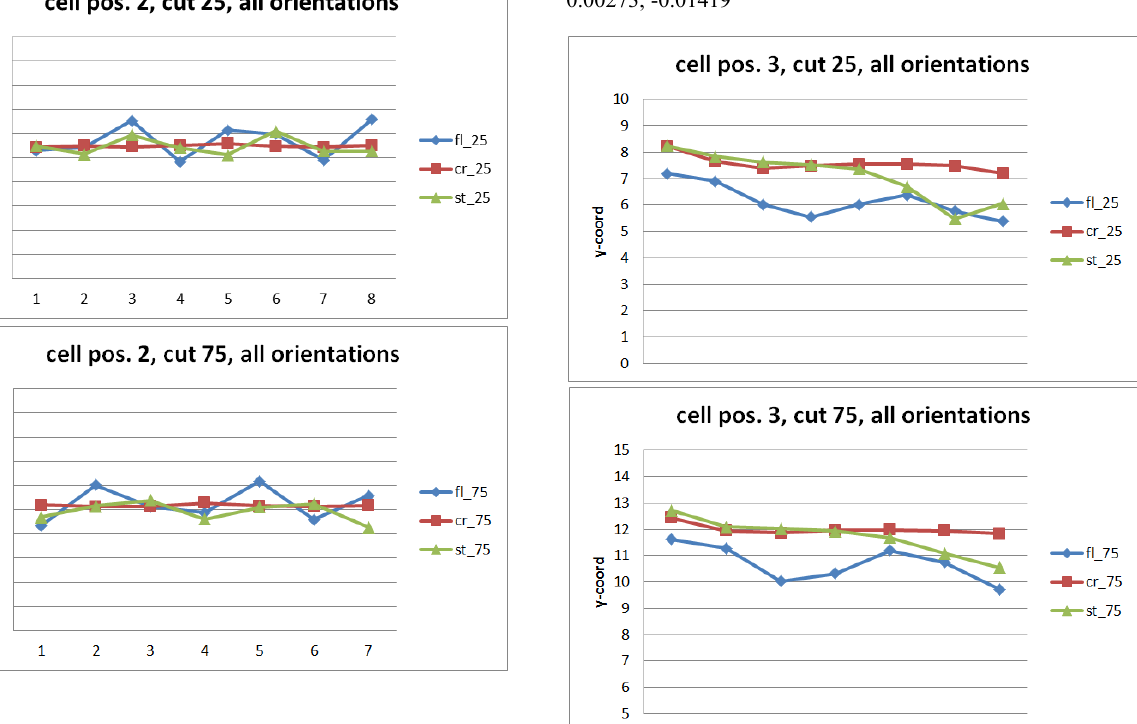
Fig.3. For cell in starting position 2 (10 μm from edge) the stability of trajectory in all cutting positions and all cell orientations is visible. The slope coefficients (in order of graphs and its lines) are 0.07207, 0.00484, -0.00748, 0.06780, -0.00037, -0.04995, 0.02895, -0.00346, -0.01948, 0.06583, 0.00273,